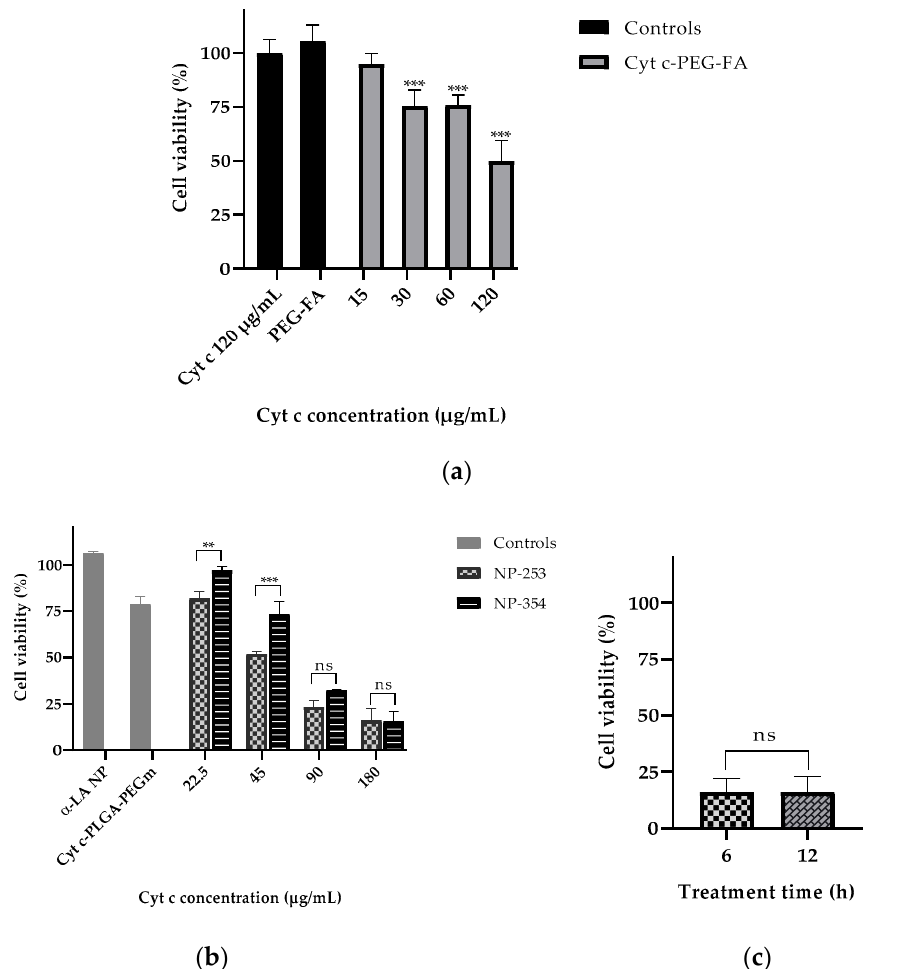
Figure 8. Cytochrome c delivery in targeted NPs efficiently reduces LLC cell viability after 6 h in a concentration-dependent manner. ( a ) LLC cell viability assay (MTS) after 6 h of treatment with Cyt c alone (120 μ g/mL) and PEG-FA (120 μ g/mL) as controls compared to the NP-free formulation Cyt c-PEG-FA at different concentrations (*** p < 0.001, n = 6). ( b ) LLC viability assay after 6 h of treatment with NPs made with non-apoptotic protein α -Lactalbumin ( α LA NP) and Cyt c-PLGA-PEG-m (m = methoxy) as controls, compared to the NP formulations NP-253 and NP-354 (** p = 0.009 and *** p < 0.001, n = 3). ( c ) LLC cell viability assay after 6 h and 12 h of treatment with NP-253 (180 μ g/mL). Error bars represent the calculated SD.